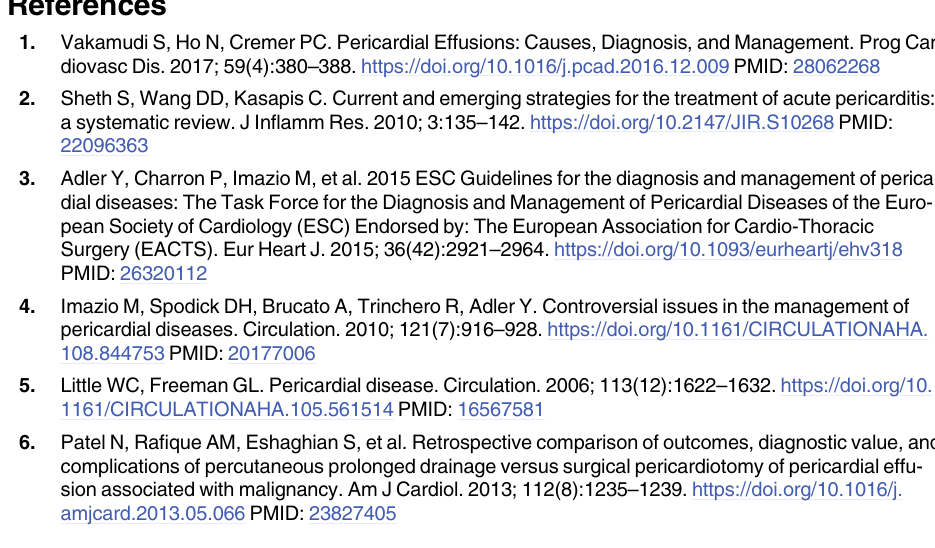
S1 Table. International Classification of Diseases, Tenth Revision (ICD-10) diagnosis and procedures codes for identifying study cohort. S2 Table. Logistic model predicting in-hospital mortality and reintervention. Abbrevia-